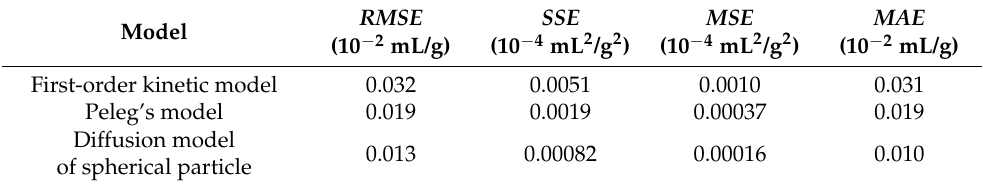
Table 3. The error results of the different